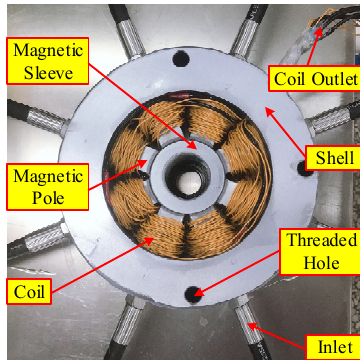
Figure 3. Photo of the Radial Unit.